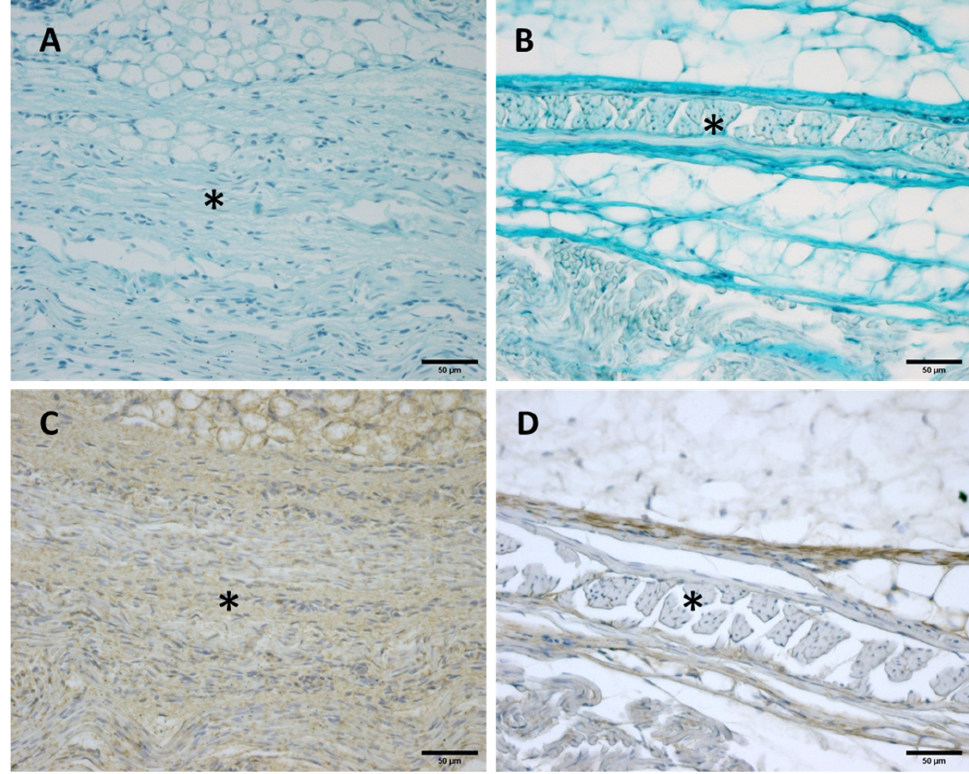
Figure 8. Alcian Blue staining and Immunostaining to detect hyaluronic acid-binding protein (HABP): anterior part of the deep fascia of thigh: ( A , C ): 24 weeks; ( B , D ): 38 weeks. (*): deep fascia. The first part of the gestation is characterized, starting from the 24th week, by less dense and irregular connective tissue with HA distributed in a disorganized manner, whilst the second part of the gestation, from the 36th week, presented with a denser and compact connective tissue with HA distributed in an organized structure which tends to diminish in